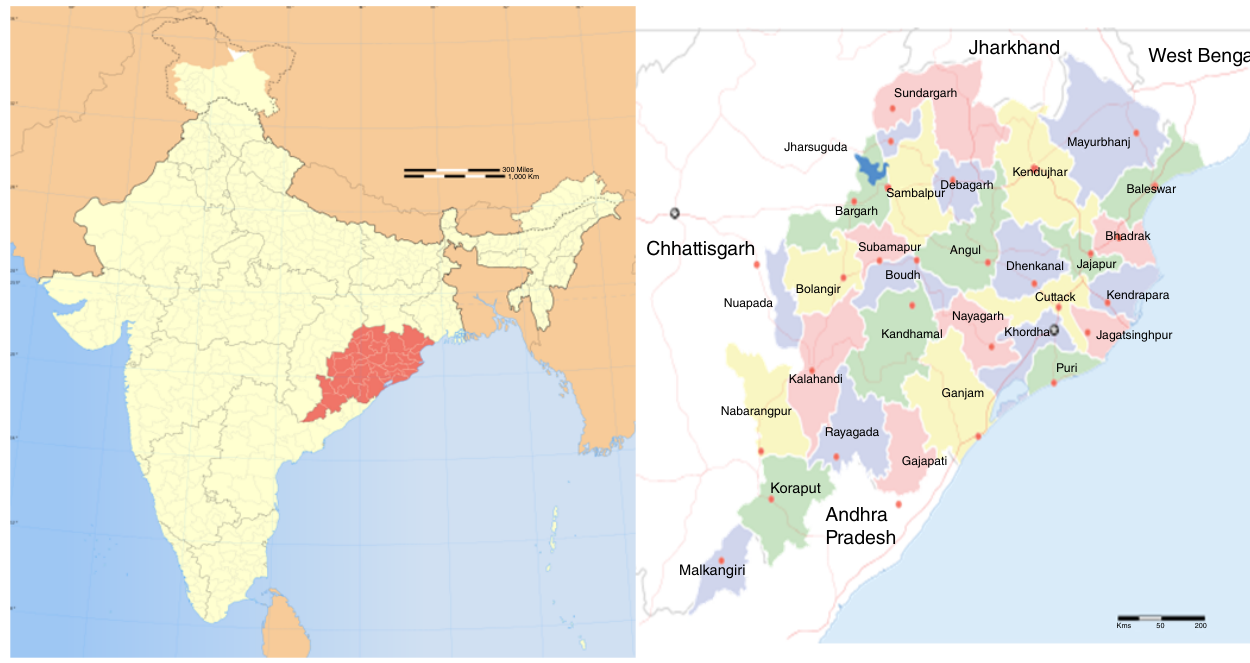
Figure 2. Geographic Location of